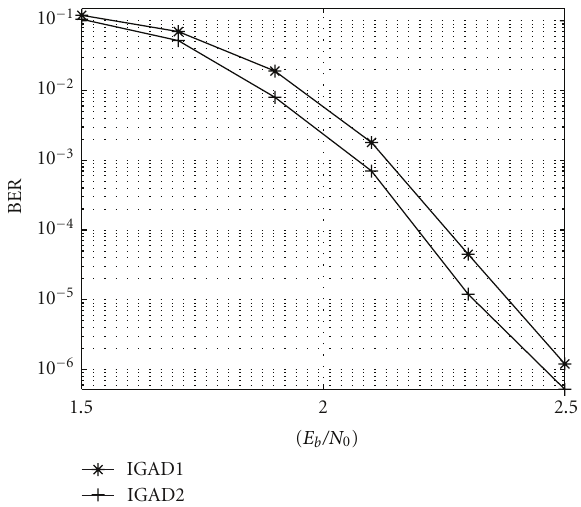
Figure 10: BER of IGAD1 and IGAD2 of (16, 11, 4) 3 for 12 iteration ( N s =